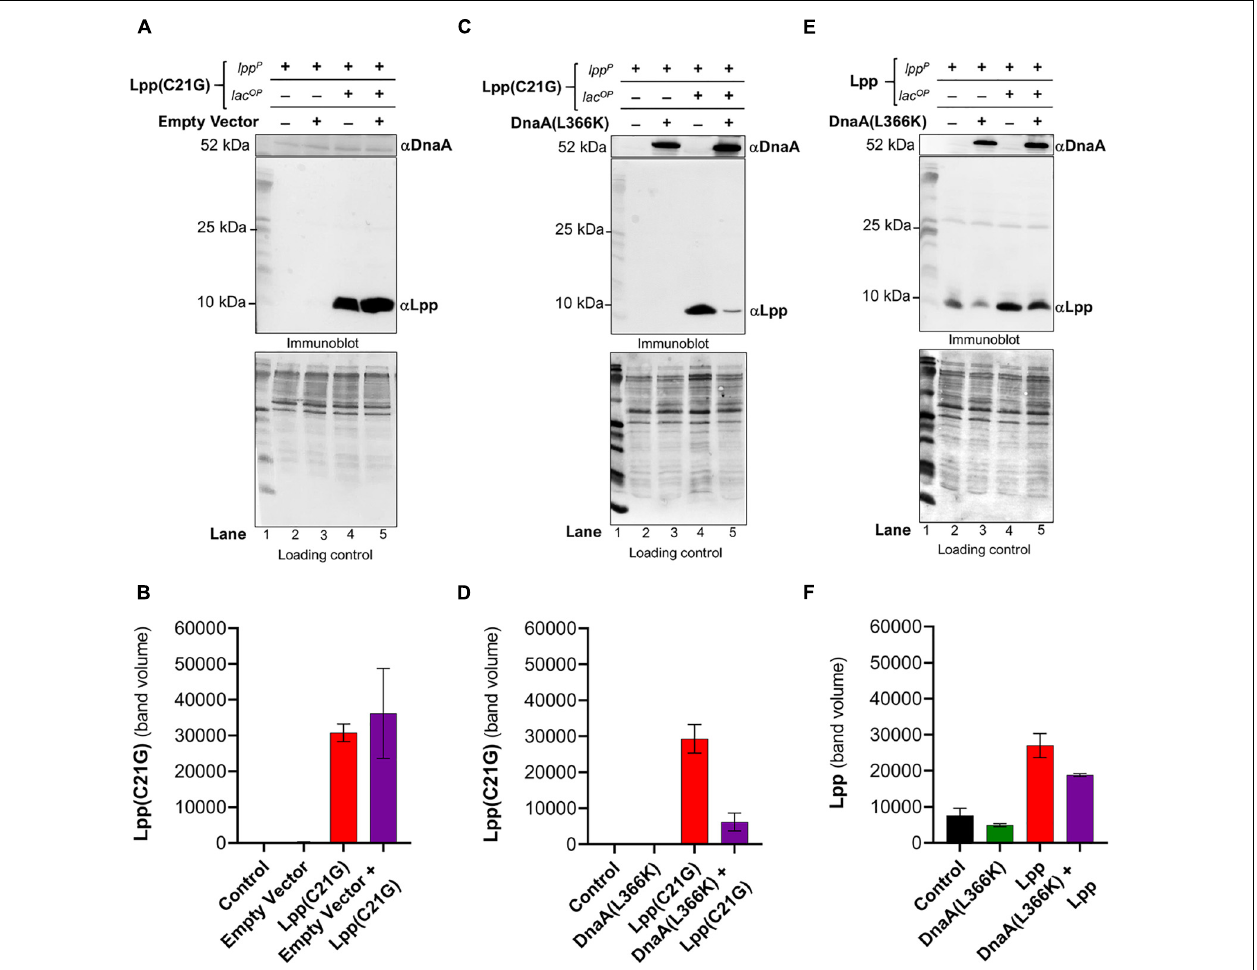
FIGURE 2 | Ecto pic expression of DnaA(L36 6K ) reduces levels of Lpp(C2 1G ) even when the inducer is present. (A,B) Immunoblotting for the detection of DnaA and Lpp(C21G) and quantitative analysis of Lpp(C21G) levels. (C,D) Immunoblotting for the detection of DnaA(L366K) and Lpp(C21G) and quantitative analysis of Lpp(C21G) levels. (E,F) Immunoblotting for the detection of DnaA(L366K) and Lpp and quantitative analysis of Lpp levels. Lpp(C21G) and Lpp are expressed via Lpp (lpp P ) and Lac (lacUV5 OP ) promoters. Loading controls for immunoblotting are ponceau-S staining for total protein normalization presented in grayscale. Data are means ± SEM of at least three independent